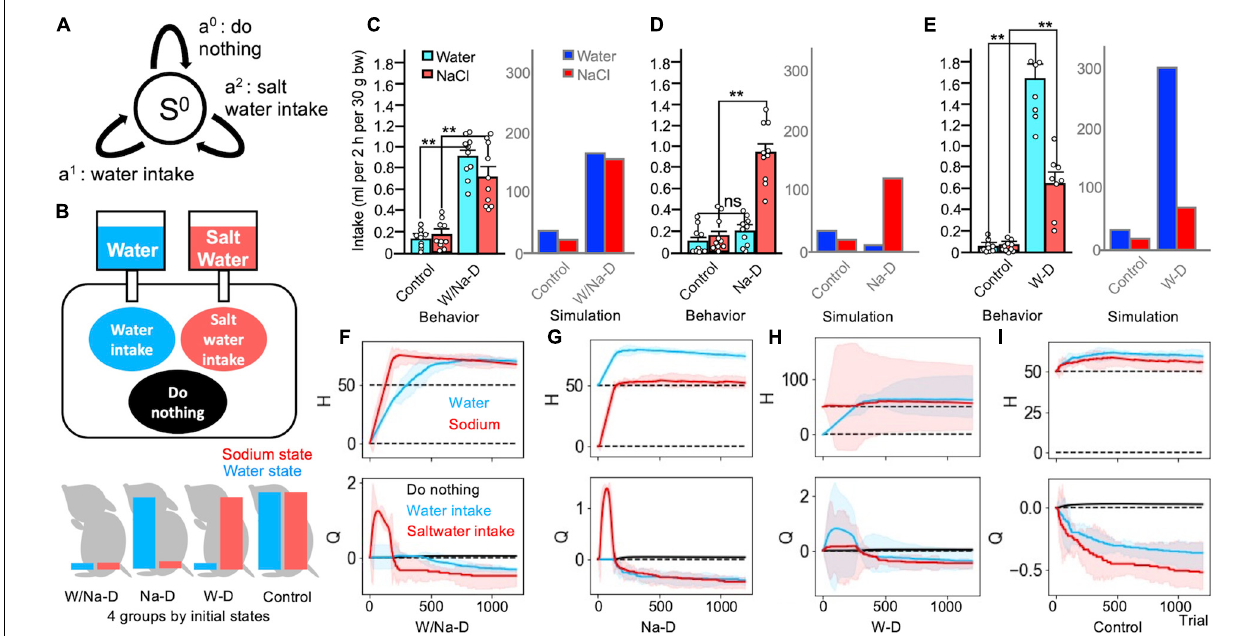
FIGURE 3 | Multi-dimensional homeostatic reinforcement learning (HRL) model as a suitable explanation of findings in the two-bottle preference test. (A) Definition of a state and three actions in Simulations 3 and 4. (B) Schematic drawing of Simulation 3 (two-bottle preference test). (C) Comparison of behavioral data (Matsuda et al., 2017) and simulated data in the control (all-satisfied) and water/sodium-depleted groups. Control groups exhibited minor intake, and both depleted groups demonstrated copious volumes of intake in both sets of data. (C–E) Data averaged over 100 simulated agents. ** P < 0.01. (D) In the sodium-depleted group, water intake was slight, while saltwater intake was increased. (E) The water-deficient groups exhibited abundant water intake and non-negligible saltwater intake. (F–I) Transitions of the HRL models. (F) The water/sodium-deficient HRL model exhibited strong increases in the values of water and saltwater intake. (G) The action value for sodium intake soared in the sodium-depleted model. (H) The water-depleted model exhibited increased values for water and saltwater intake. (I) The control model refused both intakes. (F–I) The solid lines represent the results of a trial, and the light-colored error ranges represent the mean ± 2 SD of 100 simulated